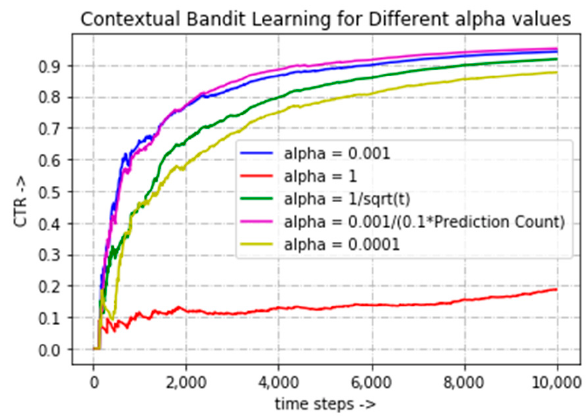
Figure 7. CTR values for different α values. As is evident from the plots, the best CTR value is achieved with α as “0.001/(number of correct selections/10)”, when the CTR value is 0.95. Subsequently, the CTR values are 0.94, 0.87, 0.91, and 0.20 for α values of 0.001, 0.0001, 1/